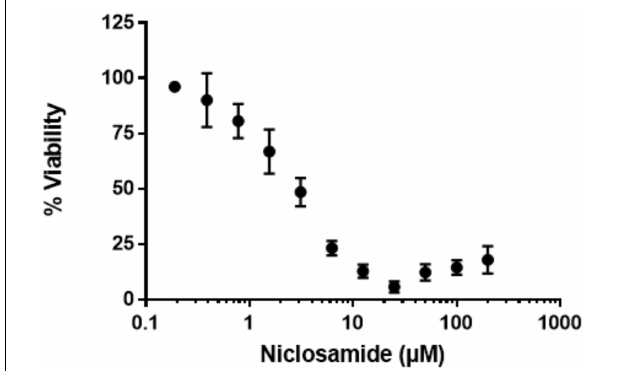
FIGURE 3 | Niclosamide has potent activity against non-replicating bacteria. Nutrient-starved bacteria were exposed to nicolsamide for 72 h. alamarBlue R (cid:13) was added, and RFU measured after 24 h. RFUs were normalized to the DMSO control to express % viability. Data are mean ± SD of four independent biological